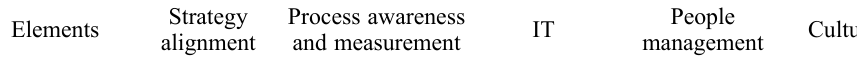
Table 3. Average marks for BPMM elements’ significance, weighed coefficients and priority